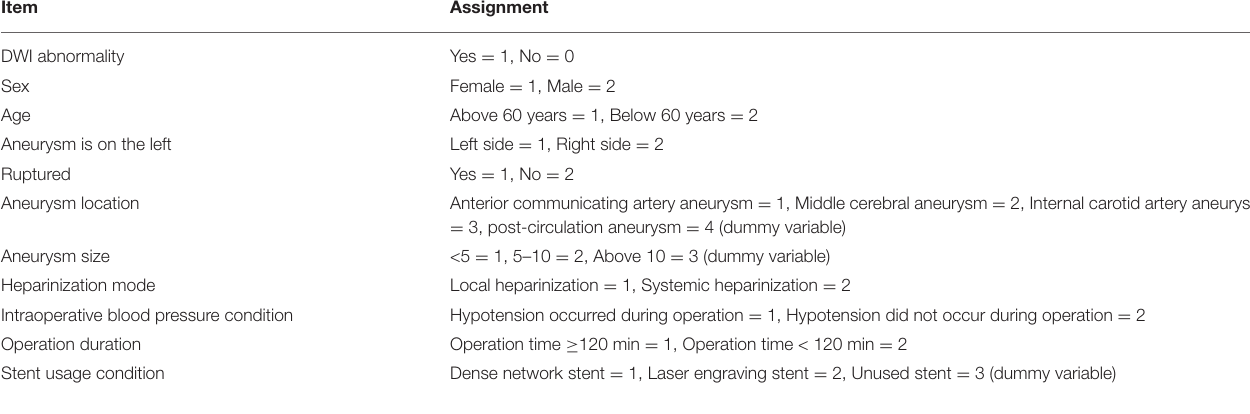
TABLE A1 | Assignment table of single-factor and multi-factor logistics regression analysis for DWI abnormalities after endovascular treatment for intracranial aneurysms.